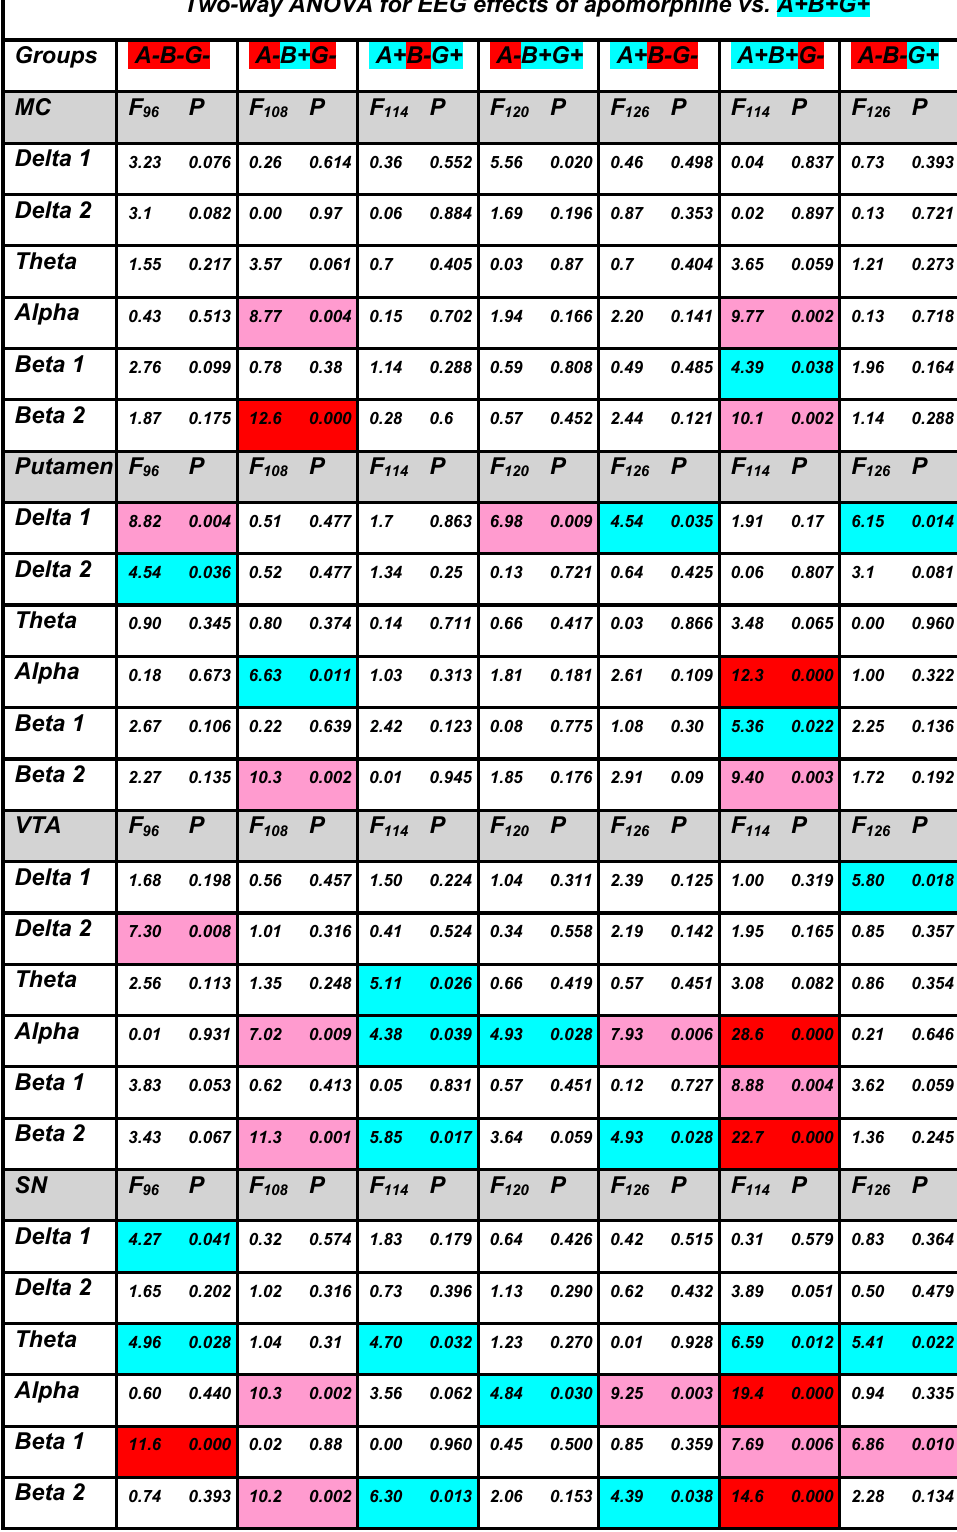
Figure A3. Results of a two-way ANOVA analysis of APO-induced changes in EEG recordings from four brain areas of synuclein KO mice vs. WT (A+B+G+) mice. Data with p < 0.05 are highlighted blue, p < 0.01 highlighted pink and p < 0.001 highlighted